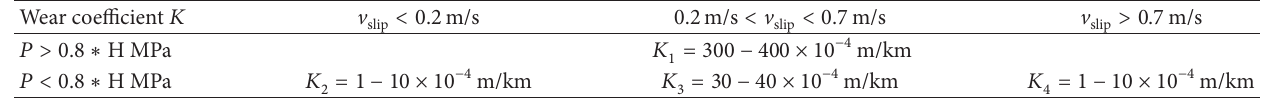
Table 2: Values of the wear coefficient according to [22].